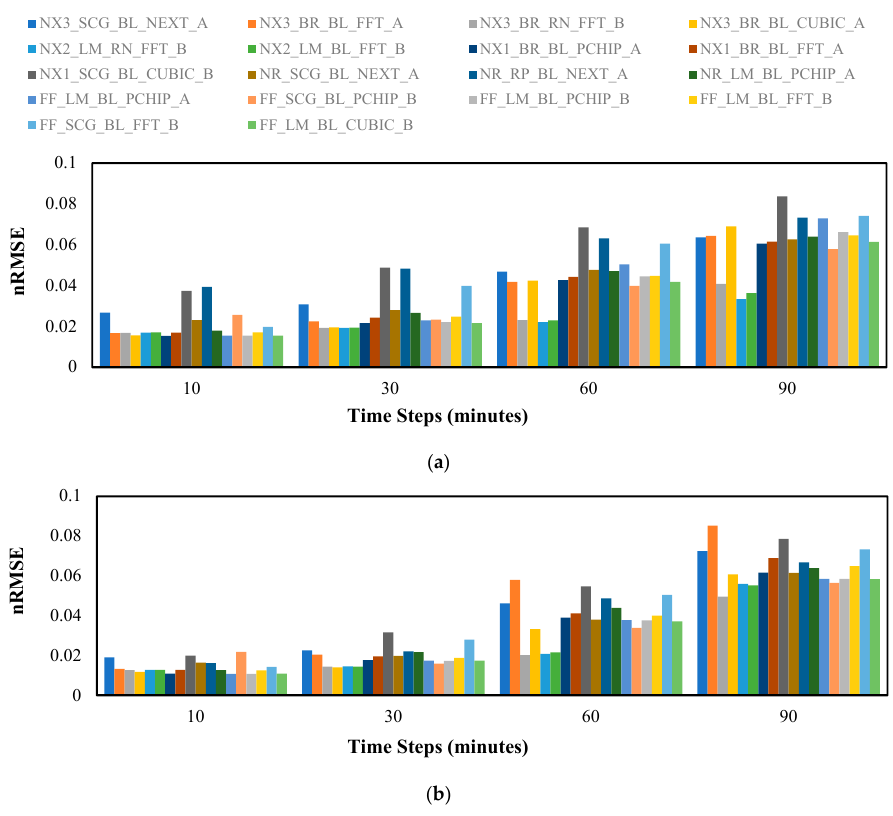
Figure 6. The 18 best ‐ performing variations in terms of nRMSE for ( a ) wind speed prediction, and ( b ) wind direction prediction. Note that 500 samples were used, each of which is a 10 min interval. This results in a total of ~83 h.